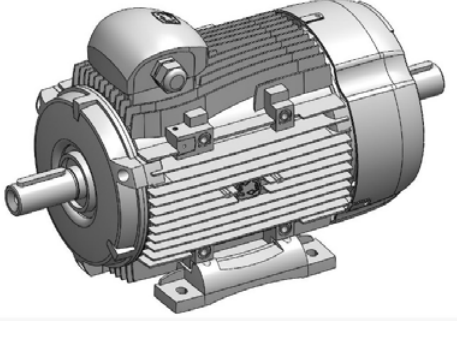
Fig. 9. DELPHI 132 MB-4-(IMB3) electric motor